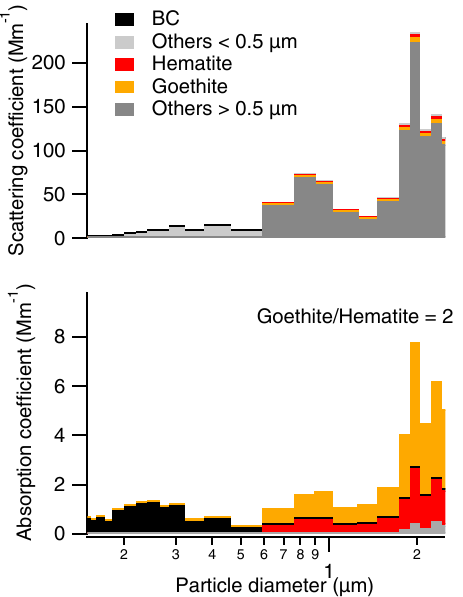
Figure 18. An example of the scattering coefficient and absorption coefficient as a function of particle size (0.1–2.5µm) for the second SLR during flight